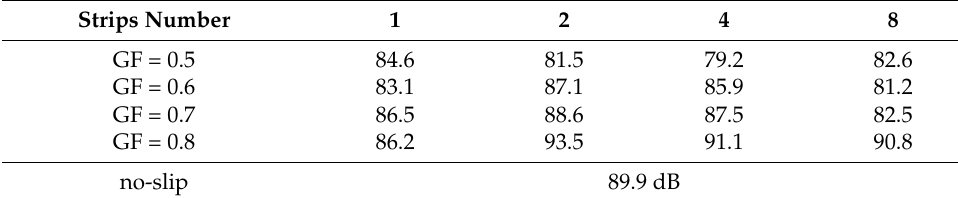
Table 4. Overall sound pressure level of different scenarios